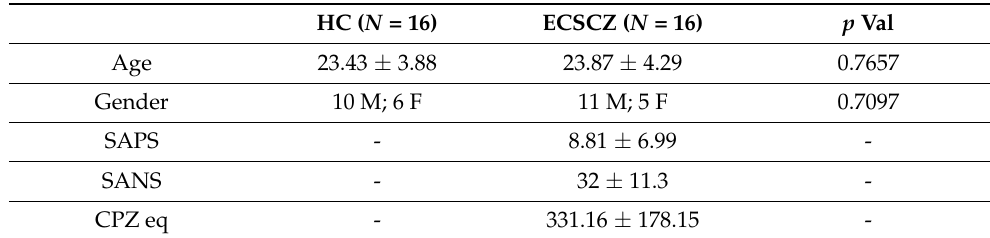
Table 1. Study population demographics. For the patients’ group, clinical rating scales and med- ication dose (expressed in chlorpromazine equivalents, CPZ eq) are reported. HC: healthy con- trols; ECSCZ: early-course schizophrenia patients; SAPS/SANS: Scale for the Assessment of Posi- tive/Negative Symptoms. HC ( N = 16) ECSCZ ( N = 16) p Val